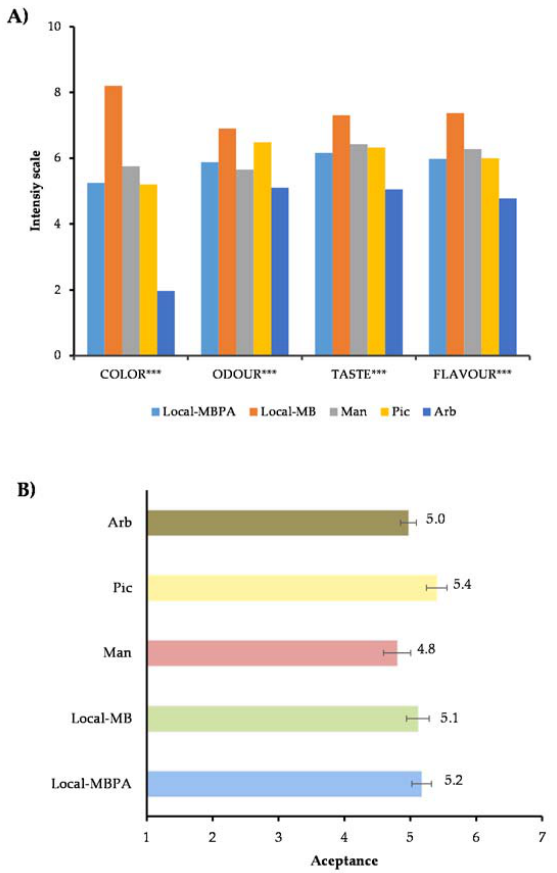
Figure 4. Intensity values obtained to sensorial attributes ( A ) and global acceptance of VOOs ( B ). *** ( P ≤ 0.001); acceptance: 1 = dislike very much; 2 = dislike moderately; 3 = dislike slightly; 4 = neither like nor dislike; 5 = like slightly; 6 = like moderately; 7 = like very much). Local ‐ MBPA (60% Mansa and Brava, 25% Picual, and 15% Arbequina); Local ‐ MB (60% Mansa and 40% Brava); Man (100% Mansa cultivar); Pic (100% Picual cultivar); Arb (100% Arbequina cultivar).